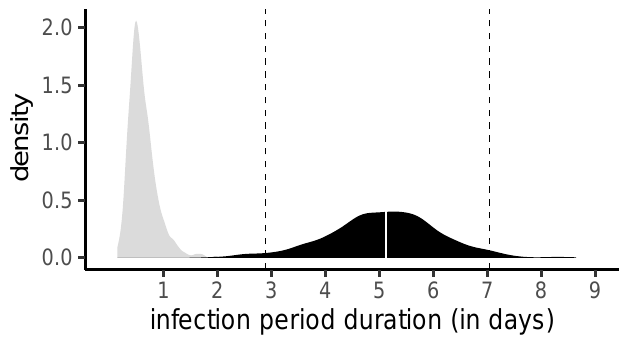
Figure 4 – Distribution of effective infection duration. The prior distribution is shown in gray, and the posterior distribution in black. The white line shows the distribution median and the dashed line the 95% highest posterior density (HPD), which is between 3 and 7 days in agreement with results obtained using contact tracing